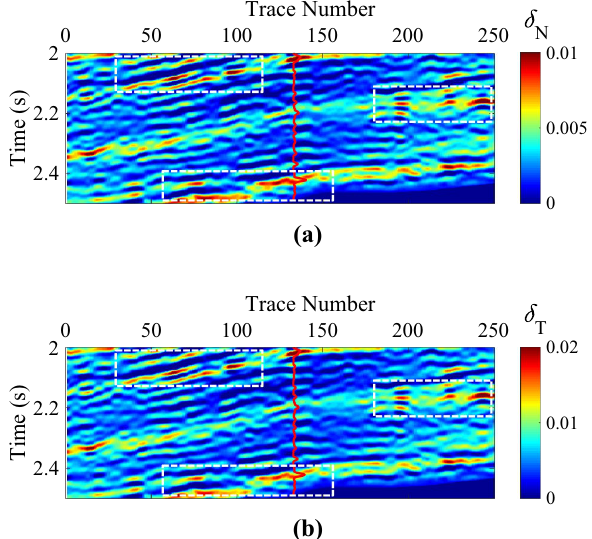
Figure 10. Inverted normal and shear fracture weaknesses in joint time–frequency domain, where (a) is the normal fracture weakness, and (b) is the shear fracture weakness, respectively.